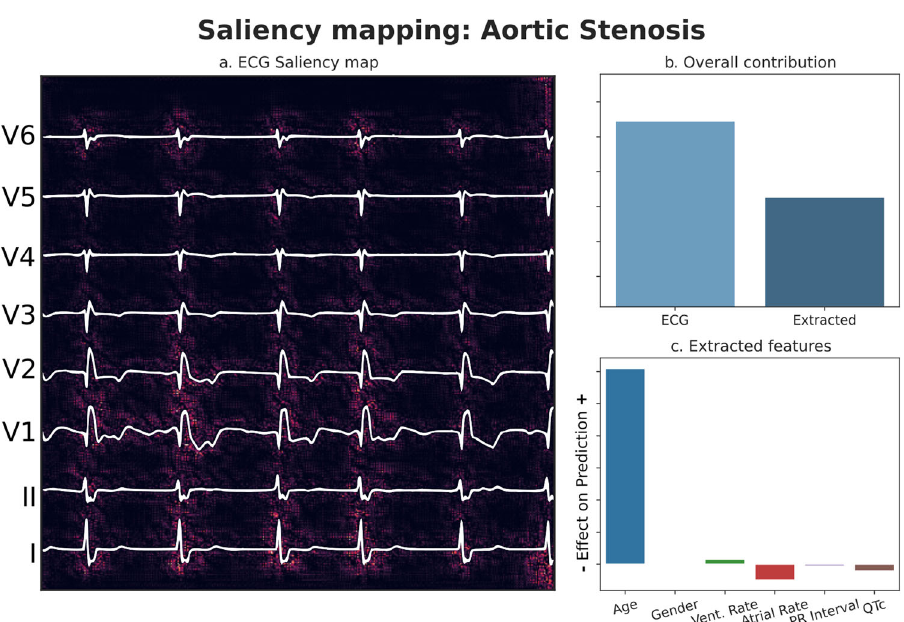
Fig. 5 Model interpretability: Aortic Stenosis. Panel a Input pixels most responsible for driving the prediction towards the outcome are highlighted. Panel b Relative contributions of waveform / tabular data to the fi nal prediction. Panel c Relative importance of tabular features with respect to each other. Patient (n = 1) was positive for Aortic Stenosis . Source data for fi gure is available in Supplementary Data